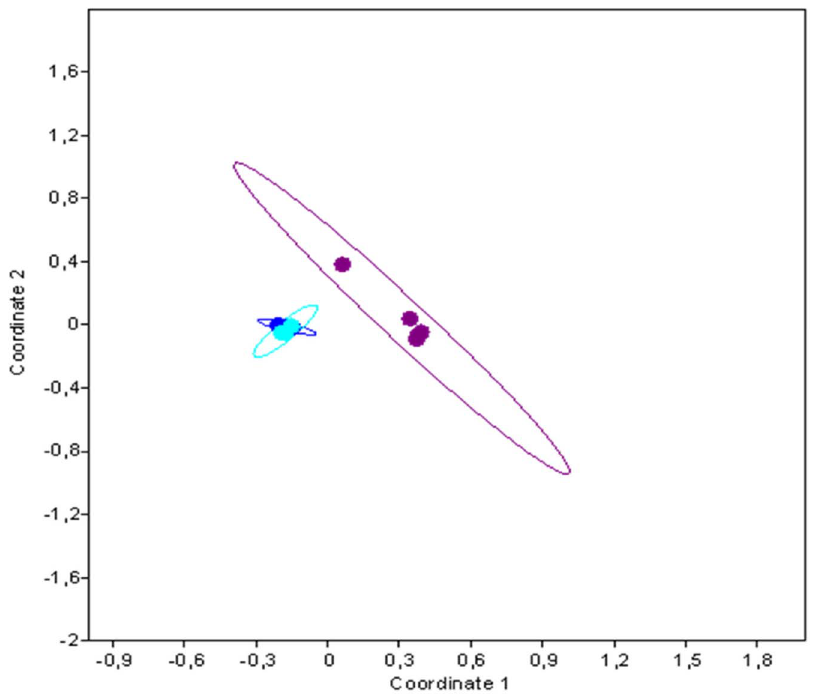
Figure 4. Ant-mimicking spider ( Peckhamiapicata ) is not a chemical mimic of its model ant ( Camponotusnearcticus ). Two-dimensional non-metric multidimensional scaling plot of chemical profiles of mimic and ants (Stress value: 0.11). Purple dots represent ant mimic profile, dark blue dots represent model ant profile, and light blue dots represent non-nestmate ant profile.